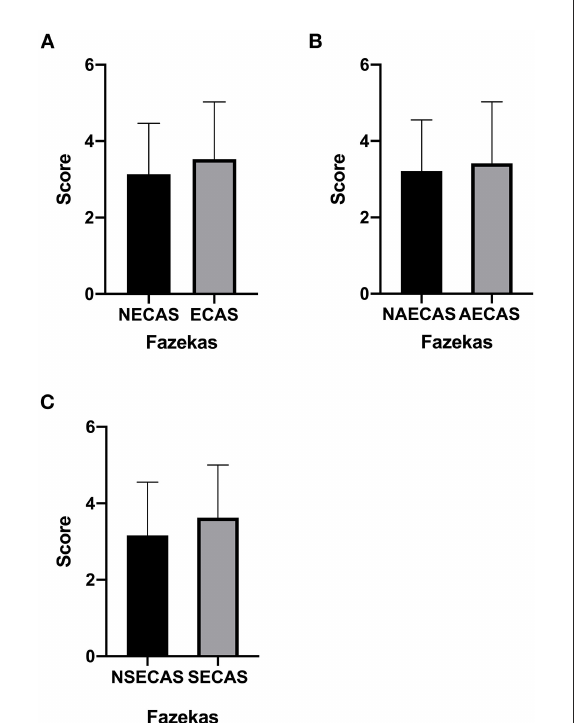
FIGURE2 (A–C) The total cerebral small vessel disease (CSVD) score in patients with or without severe extracranial arterial stenosis or occlusion, with or without severe symptomatic extracranial arterial stenosis or occlusion, and with or without severe asymptomatic extracranial arterial stenosis or occlusion. * P < 0.05 was considered to indicate statistical significance. SECAS, symptomatic extracranial arterial stenosis; AECAS, asymptomatic extracranial artery stenosis; ECAS, extracranial artery stenosis; NSECAS, no symptomatic extracranial arterial stenosis; NAECAS, no asymptomatic extracranial artery stenosis; NECAS, no extracranial artery stenosis.